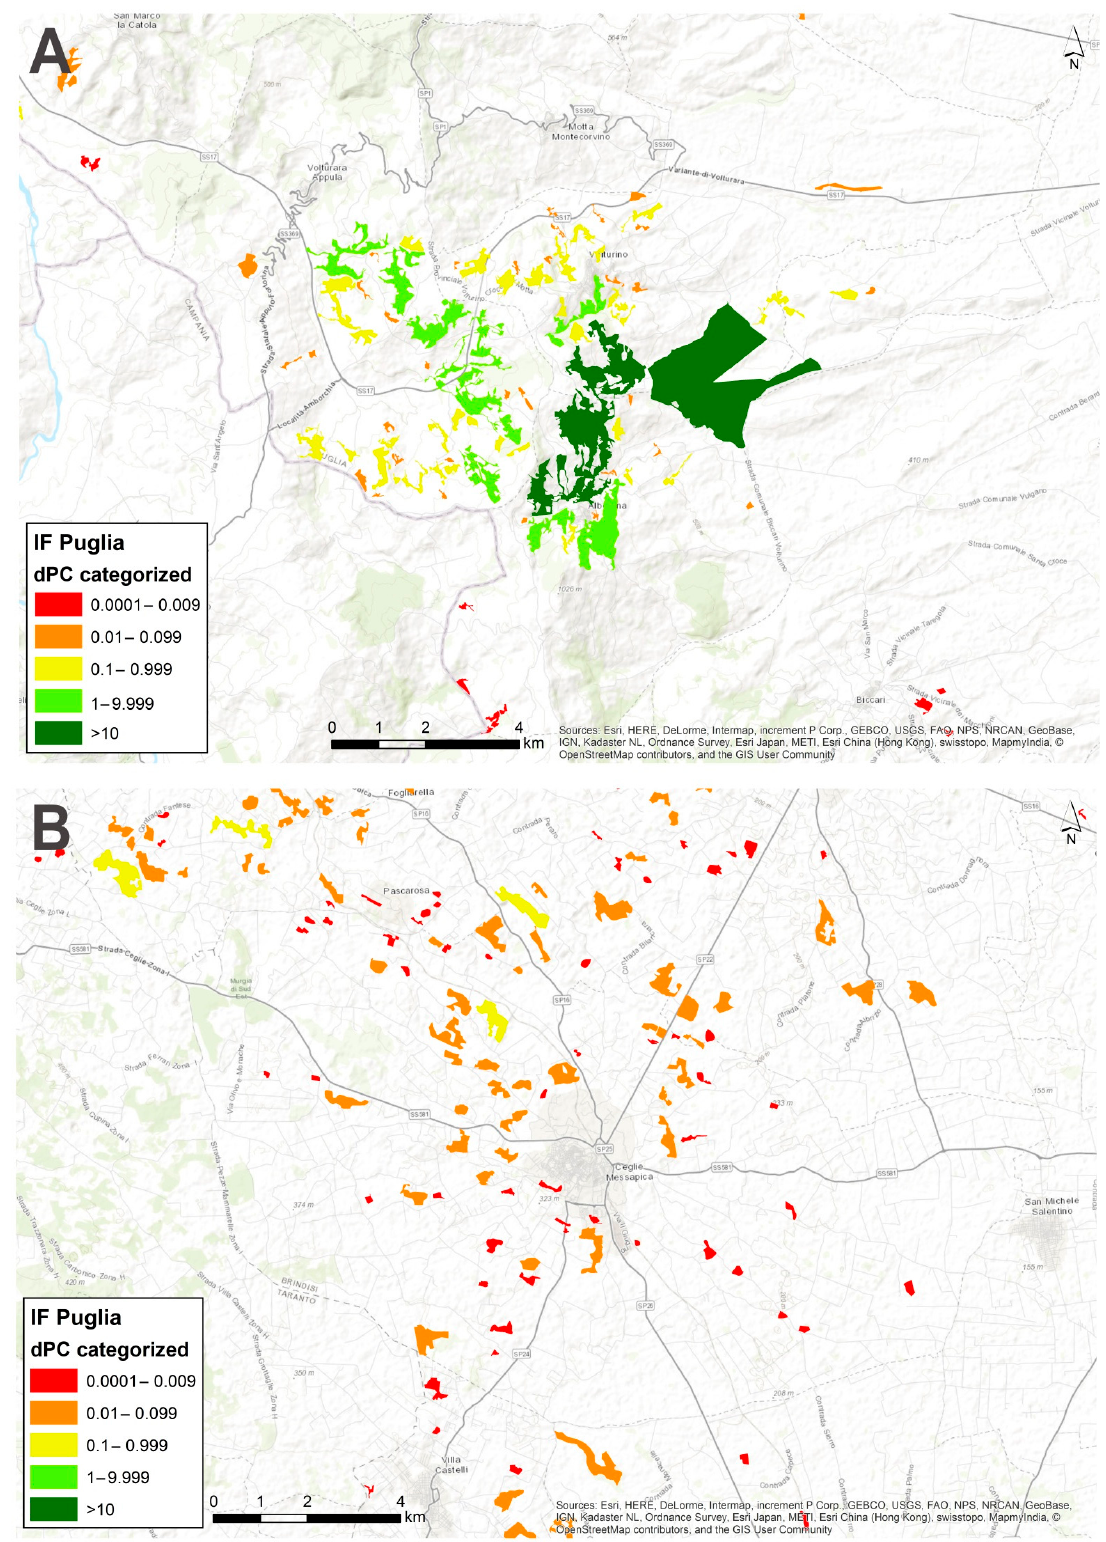
Figure 10. Two examples in the Apulia region. The first one ( A ) shows a well-defined core habitat in the area of Volturino (Foggia, Italy). The second ( B ) is an area in the surroundings of Ceglie Messapica (Brindisi, Italy) with many unconnected fragmentary IFs.